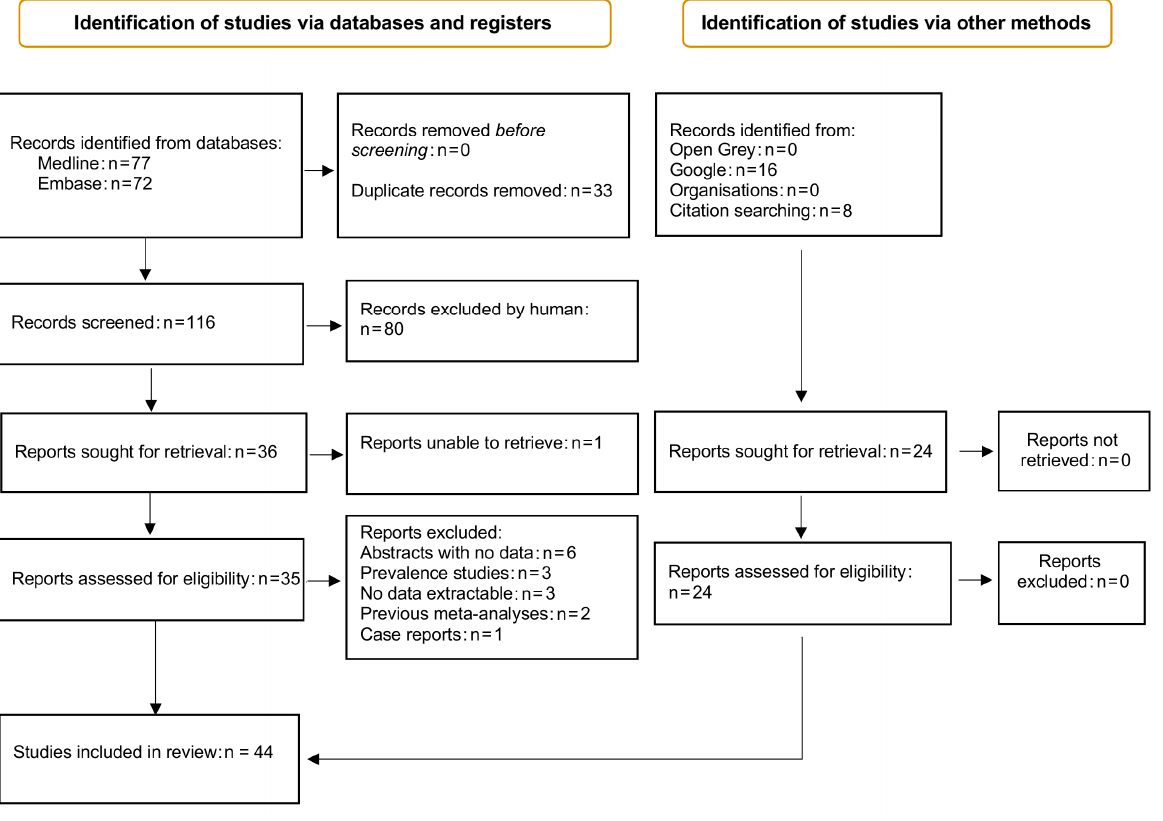
Figure 1. Prism flowchart indicating the screening and exclusion process of articles up to final inclusion in the qualitative and quantitative analysis.